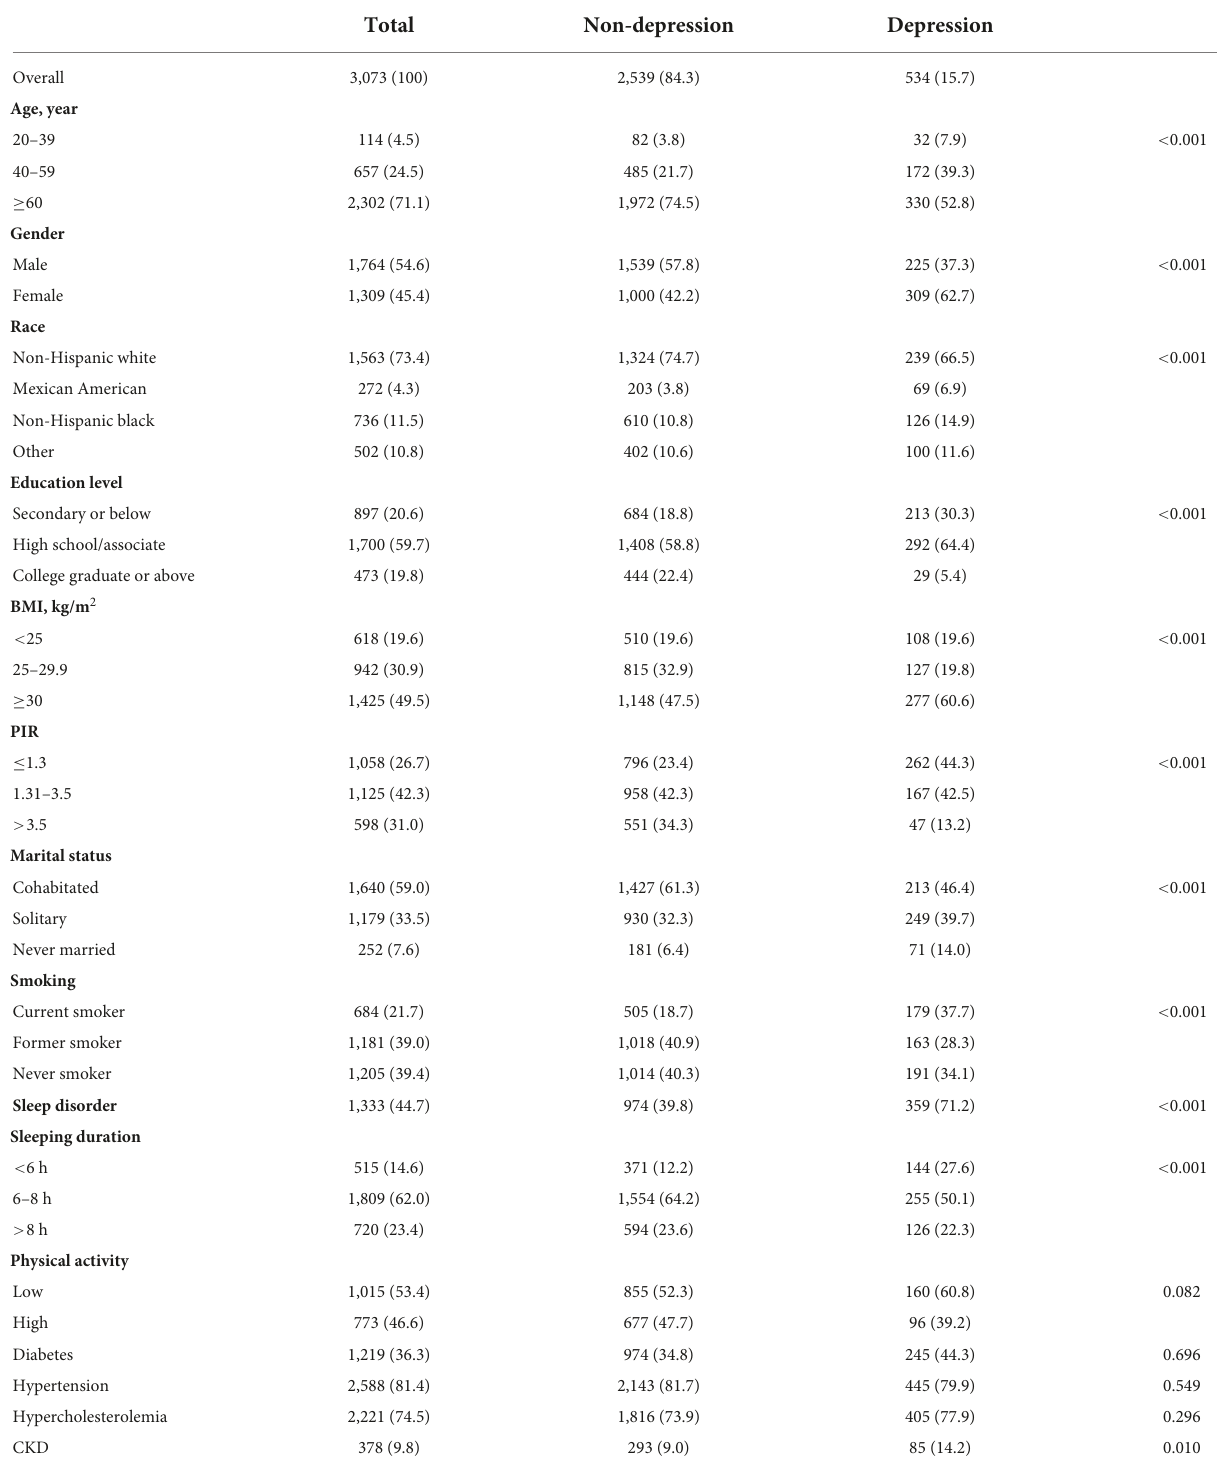
TABLE 1 Sociodemographic and clinical characteristics of participants in NAHNES 2009–March 2020.